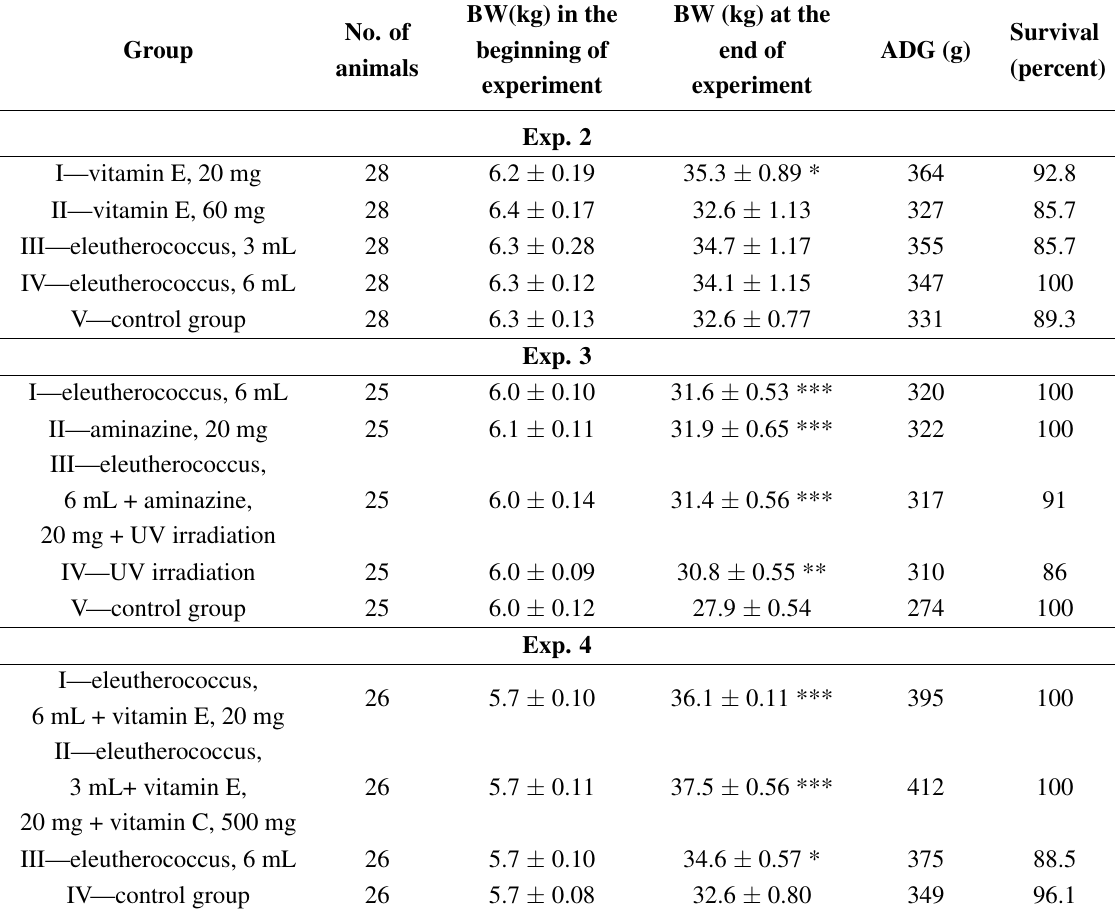
Table 2. Least squares means ± SEM for growth rate and vitality of weanling pigs under the influence of anti-stress additives. Weanling pig body weights, average daily gain (ADG), and survival rate varied by experiment and group. BW(kg) in the BW (kg) at the Survival No. of beginning of end of ADG (g) Group (percent) animals experiment experiment Exp.